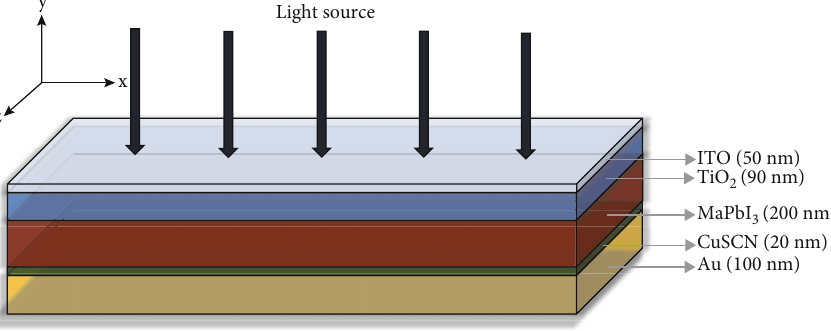
Figure 1: Sketch of PSC structure was simulated in this study; the TiO